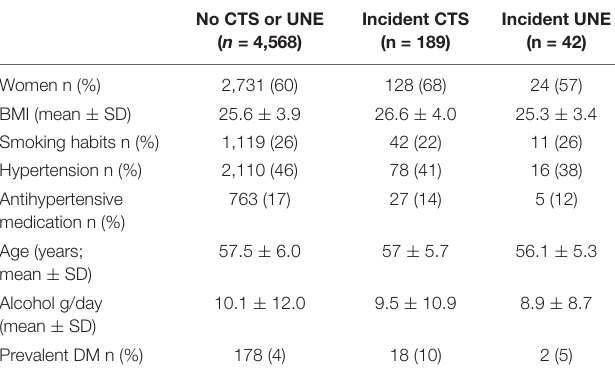
TABLE 1 | Baseline characteristics of study participants.